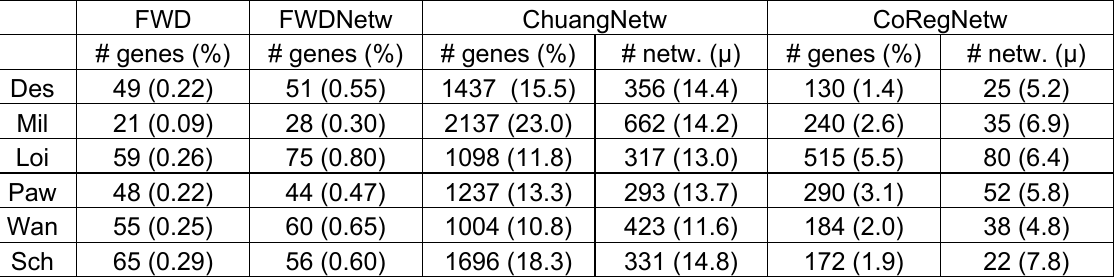
Table 2: Results of selecting predictive genes using different methods on six breast cancer studies. Forward filters (following van Vliet et al. [23]) were used to extract the optimal number of predictive genes (columns # genes (%) refer to the number and percentage of selected genes) when initially starting with all genes on the array (FWD) or all genes mapped to the PPI network (FWDNetw). The method proposed in this article (CoRegNetw) was also compared to the network approach of Chuang et al. [6] (ChuangNetw) and for methods the number of sub networks (# netw.) and average sub network sizes ( μ ) were reported also. FWD FWDNetw